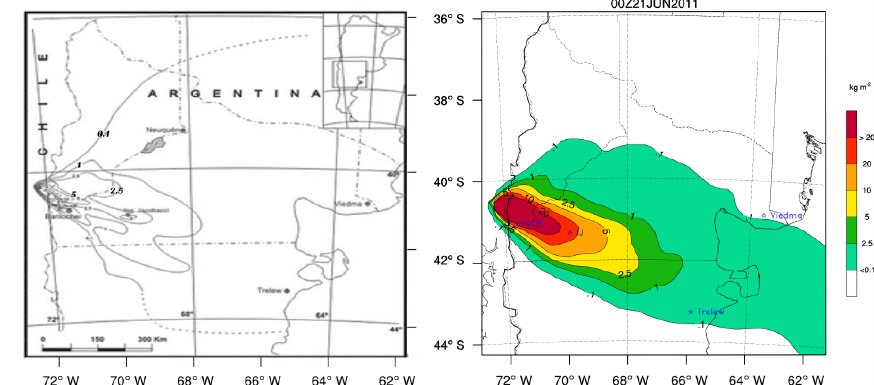
Figure 6. Left panel: measured ground deposit isopachs (kgm − 2 ) for the 2011 Caulle eruption between 4 and 30 June 2011. Dashed lines infer the limit of the deposits (modified from Collini et al., 2013). Right panel: predicted deposit load (kgm − 2 ) with NMMB-MONARCH- ASH at the end of the simulation. Key locations in blue include San Carlos de Bariloche (SCB; 90km from the vent), Ingeniero Jacobacci (IJ; 240km east of the vent), and Trelew and Viedma ( ∼ 600km SE and NE of the vent,